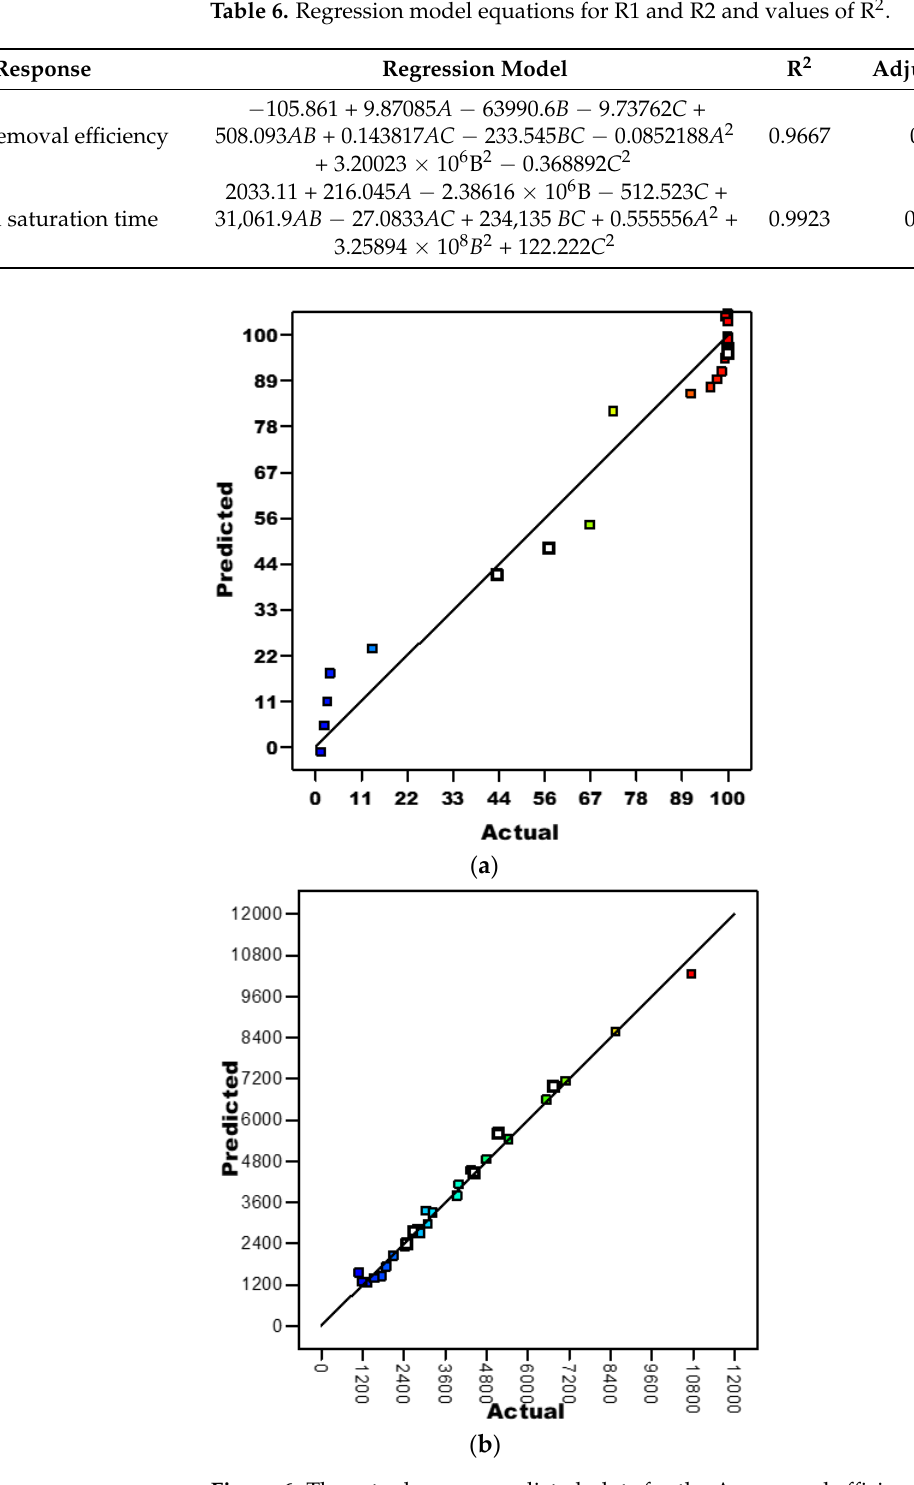
Figure 6. The actual versus predicted plots for the As removal efficiency ( a ) and the bed saturation time ( b ).